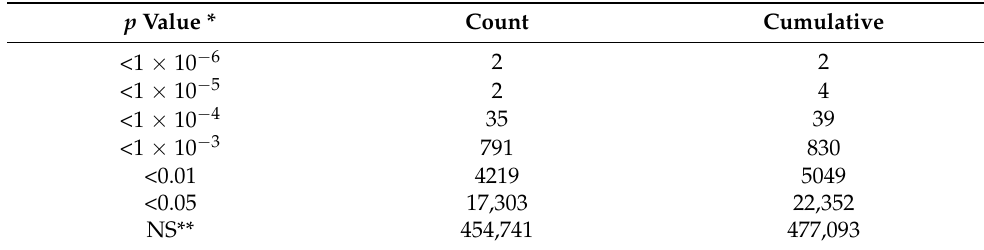
Table 2. Detailed information of single nucleotide polymorphisms (SNPs) analyzed in this study.